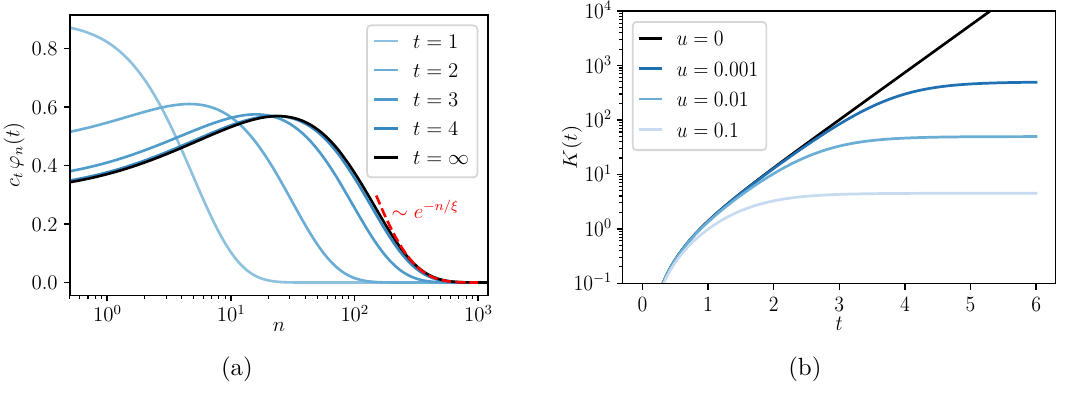
Figure 4 . (a) Snapshots of the wave-function on the Krylov chain, from the exact solu- tion (6.8), (6.10) with η = 1 . 5 and u = 0 . 01 . For display, we rescaled the wavefunctions by a t -dependent constant; we also interpolated ϕ n to non-integer values of n . At t → ∞ , a stationary profile is reached with an exponential tail ∝ e − n/ξ with ξ = 1 /u , indicated by the dashed curve. (b) Growth of the K-complexity for various dissipation strength ( u ), from the exact solution (6.15). The exponential growth, which lasts indefinitely in the closed system ( u = 0 ), saturates at t ∼ ln(1 /u ) , or K ( t ) ∼ 1 /u , in the presence of